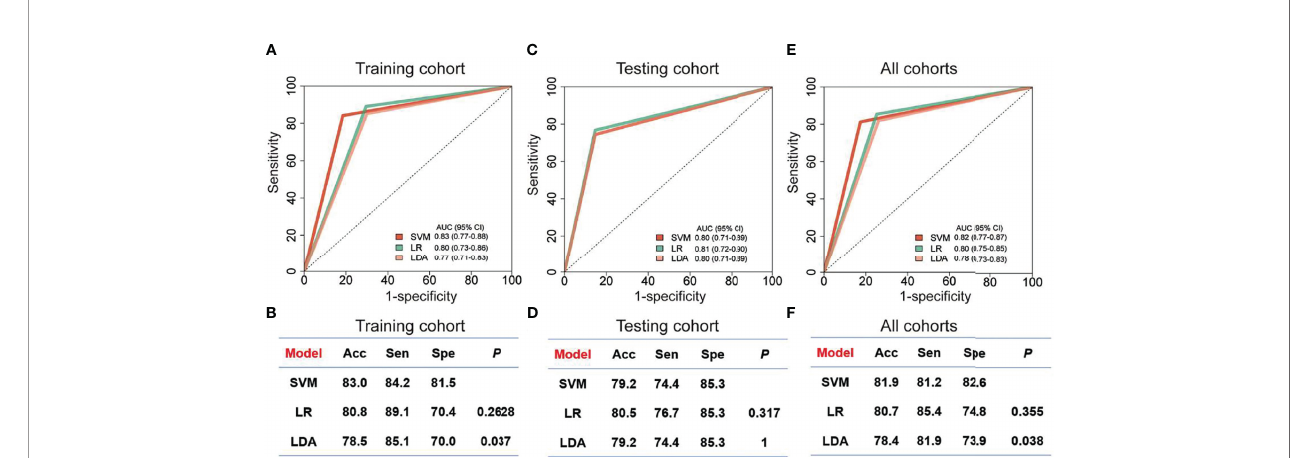
FIGURE 4 | Performance of classi fi ers for breast cancer prediction. The performance of training cohort (A, B) , testing cohort (C, D) and all sample (E, F) with three models was showed. The AUC in the training cohort was cross-validated using leave one out cross-validation (LOOCV). Receiver operating characteristic, ROC; Acc, accuracy; Sen, sensitivity; SVM, support vector machine; LDA, linear discriminate analysis; LR, logistic regression; Spe, speci fi city; P, the P -value of DeLong's